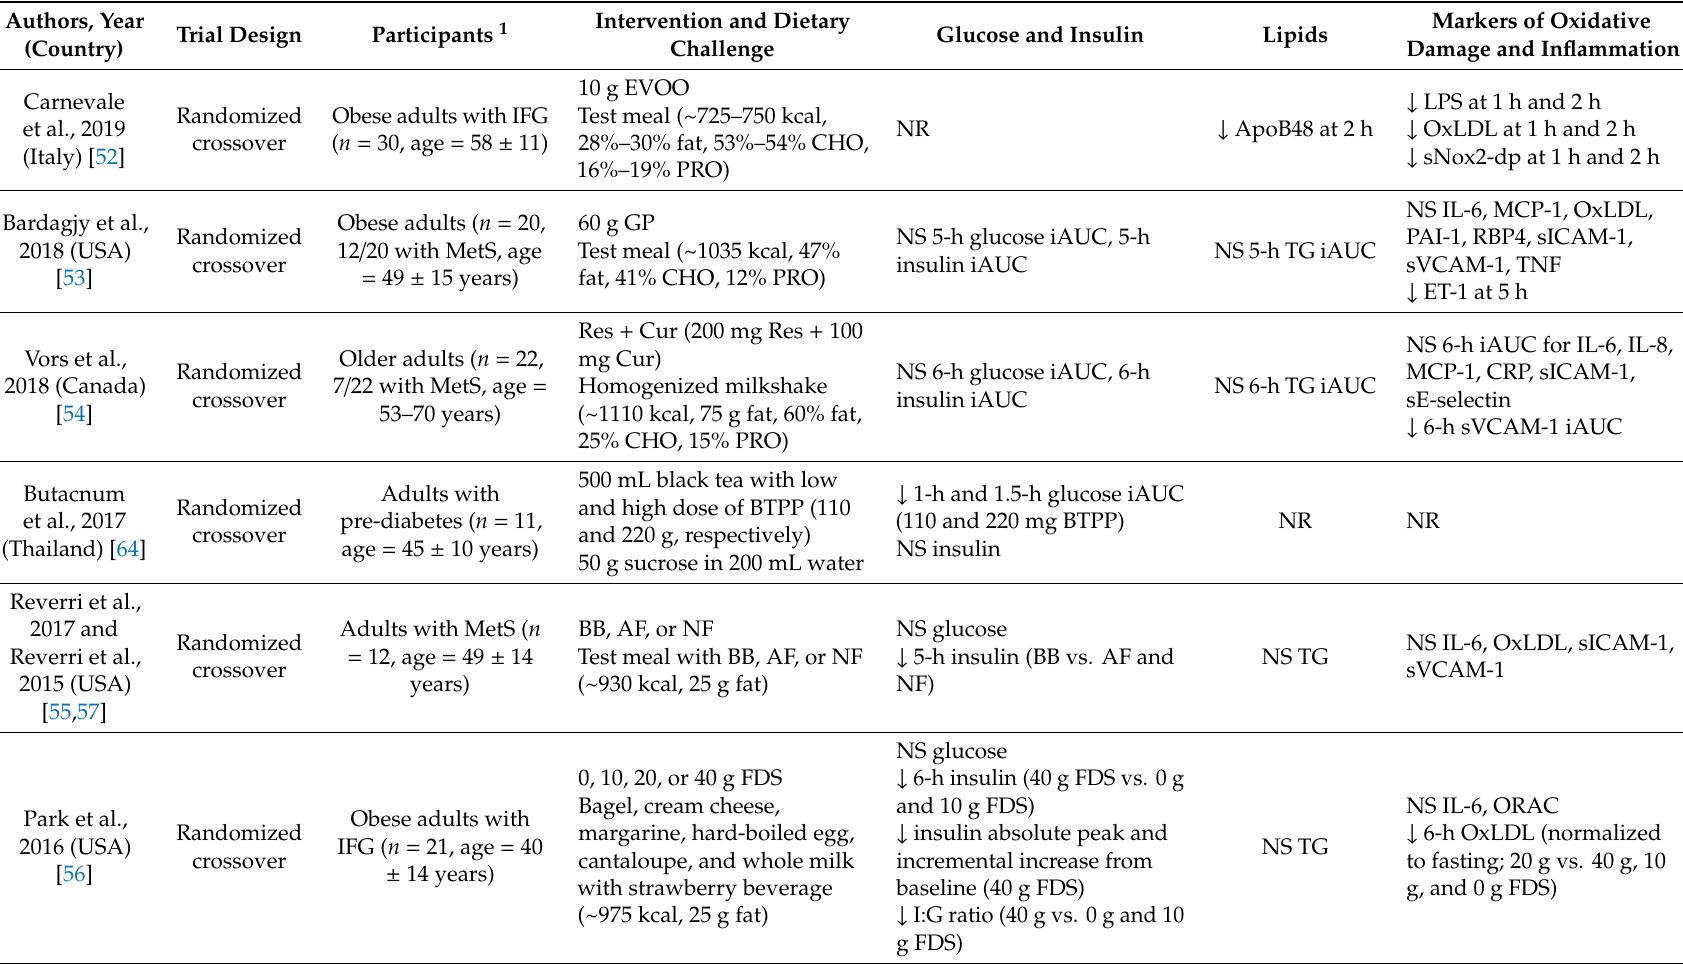
Table 1. Clinical trials on the e ff ects of acute oil-, fruit-, tea-, and legume-derived dietary polyphenol supplementation on postprandial glucose, insulin, lipids, and markers of oxidative damage and